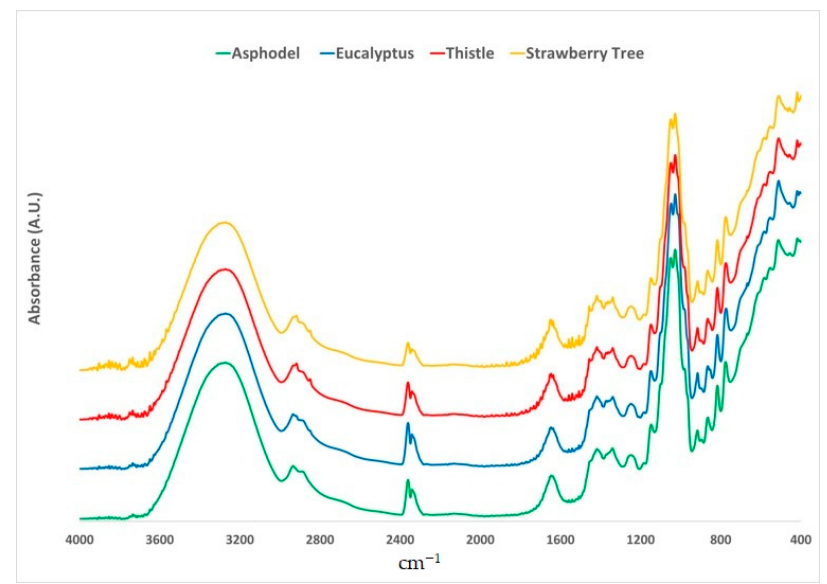
Figure 1. Average raw ATR-FTIR spectra of the selected floral origins.